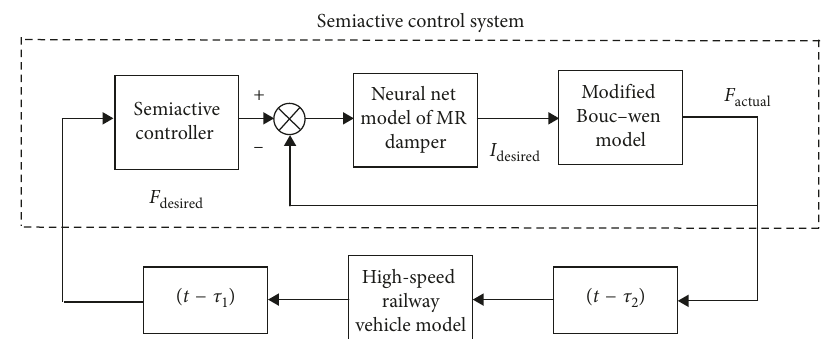
Figure 21: Two kinds of time delay of the semiactive control system based on MR